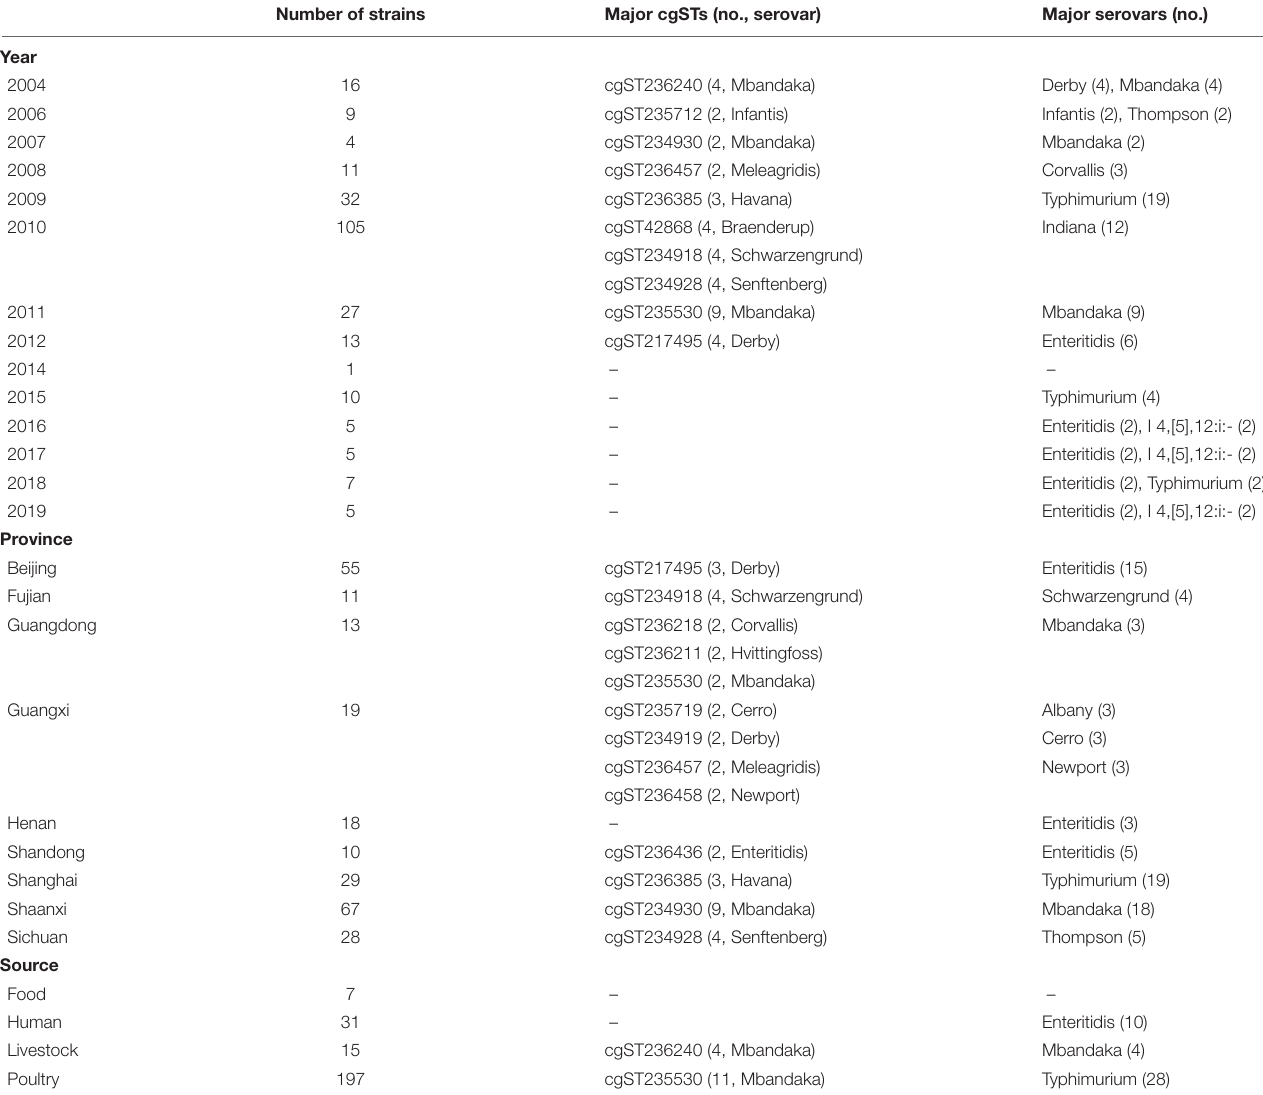
TABLE 2 | Major cgSTs and major serovars of S. enterica isolates. Number of strains Major cgSTs (no., serovar) Major serovars